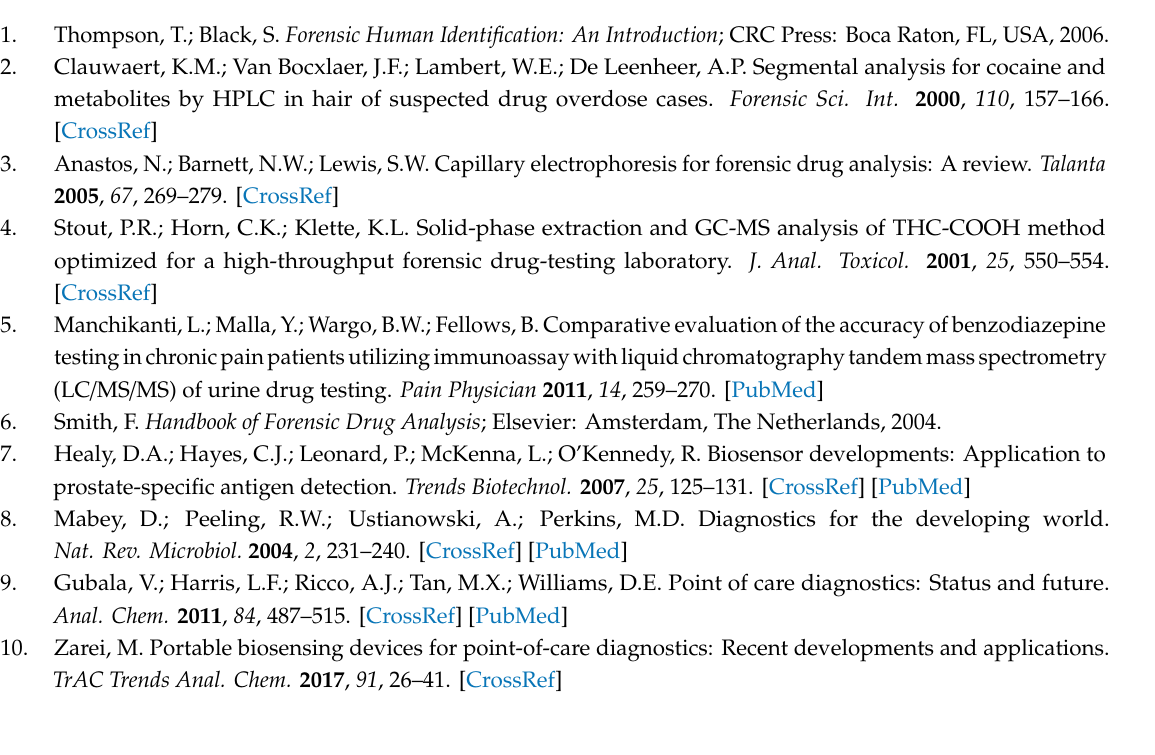
Table S1: Binding a ffi nity and post-SELEX optimization of aptamers selected for abused drugs, Table S2: Literature survey of optical aptasensors for abused drugs, Table S3: Literature survey of electrochemical aptasensors for abused